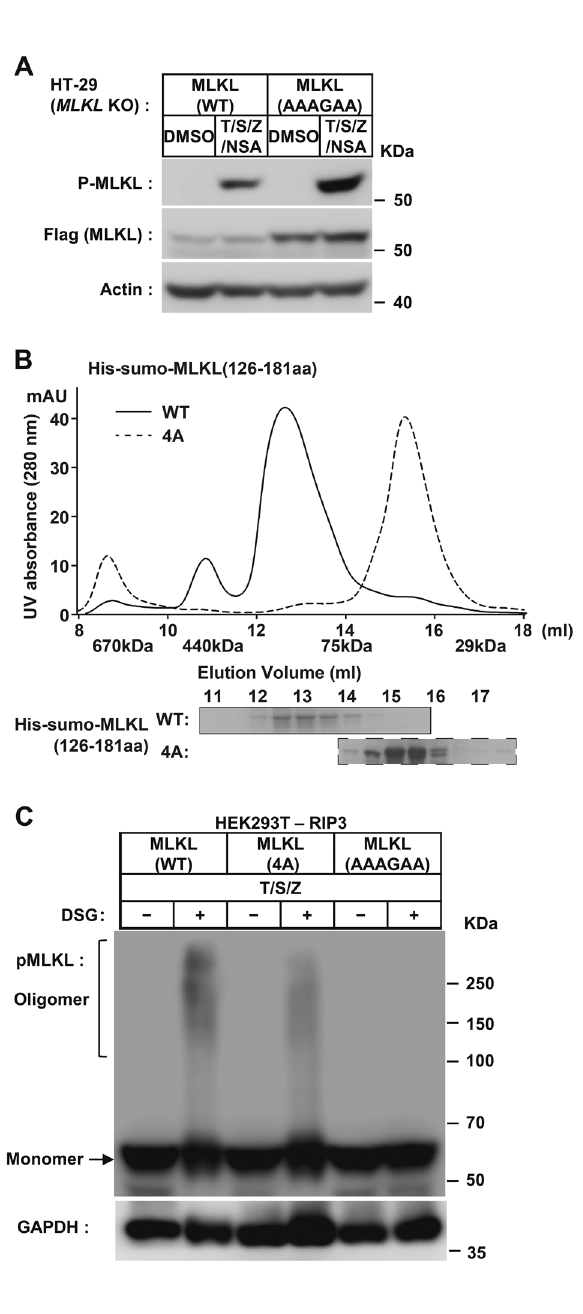
Fig. 2 MLKL kinase-like domain dimerization is required for MLKL-dependent necroptosis. A Overall structure of MLKL kinase-like domain dimer (green and cyan), illustrating the central and the side of dimer interface. The interface residues involved in intermolecular bonding are shown in sticks. B A close-up view on the side of the dimer interface. Arg224 of one MLKL molecular interacted with Glu460 of the other molecular by ionic bond. The phenyl rings from Tyr318 of one MLKL molecular hydrophobic interacted with the hydrocarbon chain of Arg224 and backbone of His223 of the other molecular. Ionic bond is in this and all other fi gures are represented by red dashed lines. C , D Close-up views on the center of dimer interface. Glu258 of one MLKL molecule ionically interacted with Arg264 of the other molecule. Pro260 of one MLKL and Phe266 of the other molecular stack against each other by CH/ π interaction. E , F The effect of dimerization mutants of MLKL on necrosis. MLKL KO HT-29 cells stably expressing C-terminal fl ag-tagged wild-type (WT) or dimerization mutants H223A/R224A and R264A/ F266A (E) or H223A/R224A/E258A/P260G/R264A/F266A (AAAGAA) (F) of MLKL by lentivirus infection were treated with T/S/Z for the indicated time. The number of surviving cells was determined by measuring ATP levels using the CellTiter-Glo kit (lower panel). The data are presented as the mean ± SD of duplicate wells. Similar results were obtained from at least three independent experiments. Abbreviations are as follows: T, TNF- α ; S, Smac mimetic; Z, z-VAD-fmk. The fi nal concentrations of 10 ng/ml TNF- α , 100 nM Smac mimetic, and 20 μ M z-VAD-fmk were used. Identical concentrations of these necroptosis-inducing agents were used in subsequent experiments unless otherwise stated. The untreated cells were harvested and whole-cell extracts were prepared and normalized to the same concentration. Aliquots of 20 μ g whole-cell lysates were subjected to SDS-PAGE followed by western blot analysis of MLKL(by anti-Flag antibody) and β -Actin which is shown as a loading control (upper panel).